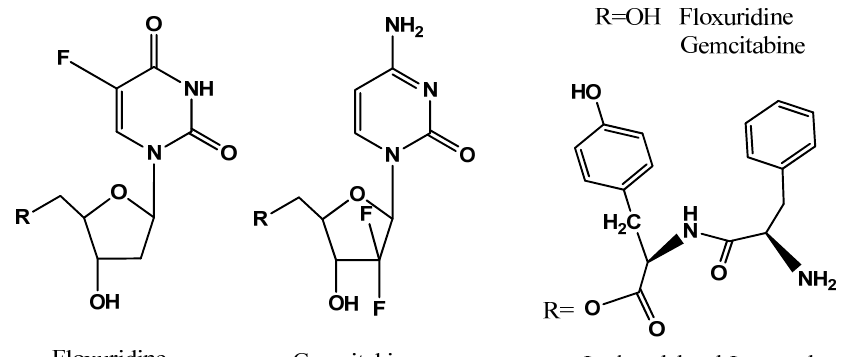
Figure 1. Dipeptide monoester prodrugs of floxuridine and